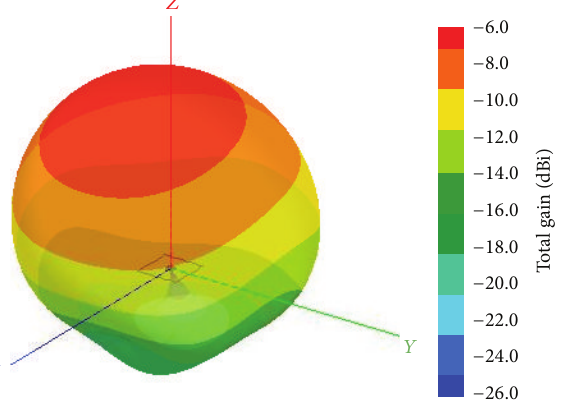
Figure 13: Simulated radiation pattern for a 20 × 20 cm 2 metal plate.